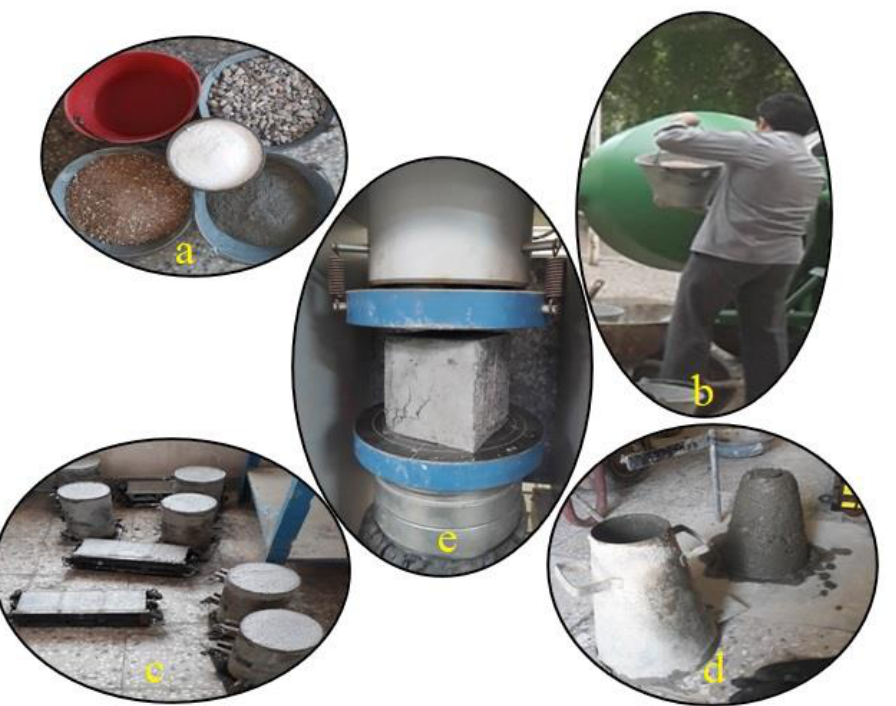
Figure 1. The casting and testing of the mechanical properties concrete modified with eggshell powder: ( a ) mix design, ( b ) mixing the concrete, ( c ) casting the concrete in a mold, ( d ) slump test, and ( e ) compressive strength test. Table 4. Concrete mix